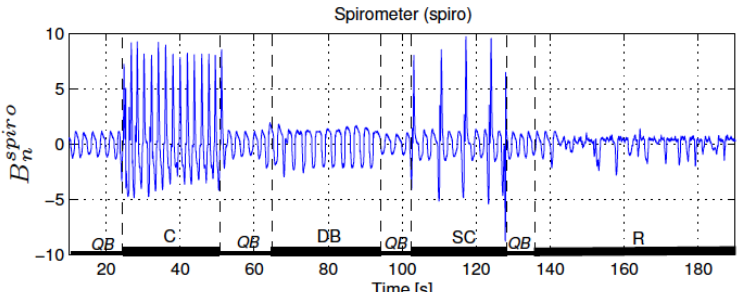
Figure 4. A reference measurement of the respiratory activity, the airflow at the mouth and nose was measured using a spirometer [8].